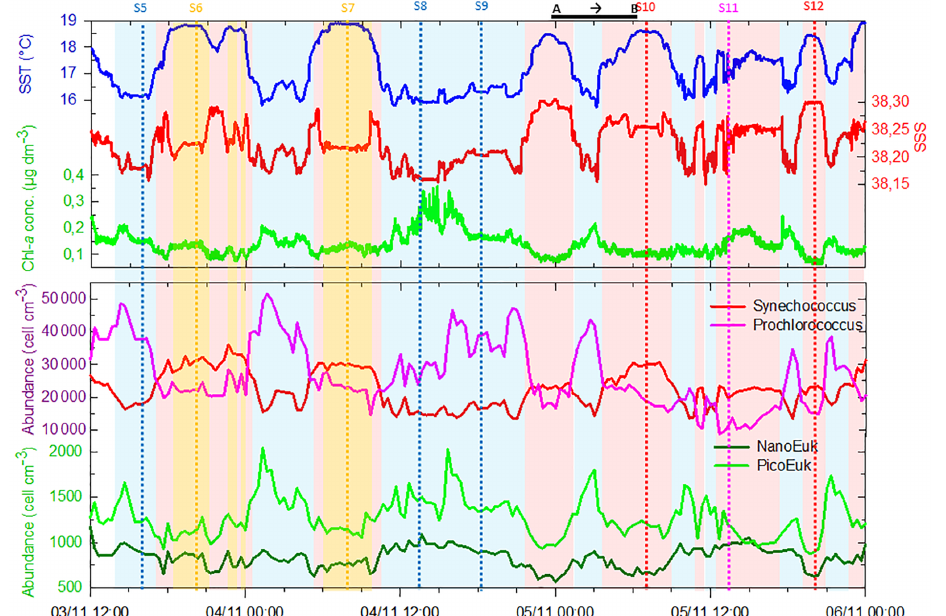
Figure 6. Continuous measurements of SST (in ◦ C), SSS and Chl a concentrations (in µgdm − 3 ) of surface waters during the OSCAHR campaign from 3 November 12:00 to 6 November 00:00 (local time), with associated surface abundances (in cellscm − 3 ) of Prochlorococcus , Synechococcus , picoeukaryotes (PicoE + PicoHighFLO + PicoHighFLR) and nanoeukaryotes (NanoE + NanoFLO + NanoHighFLO). The background color code corresponds to cold core surface waters in blue, warm boundary waters of type 1 in red and warm boundary waters of type 2 in orange (more details in Sect. 4.2). Vertical dashed lines represent sampling times of the eight fixed stations (STA5 to STA12) performed during the campaign and colors correspond to the type of surface waters in which stations were performed. The purple color for STA11 shows that STA11 was performed in transition surface waters between cold core and warm boundary 1 surface waters. Start and end of the MVP transect presented in Fig. 3 are represented by a horizontal black